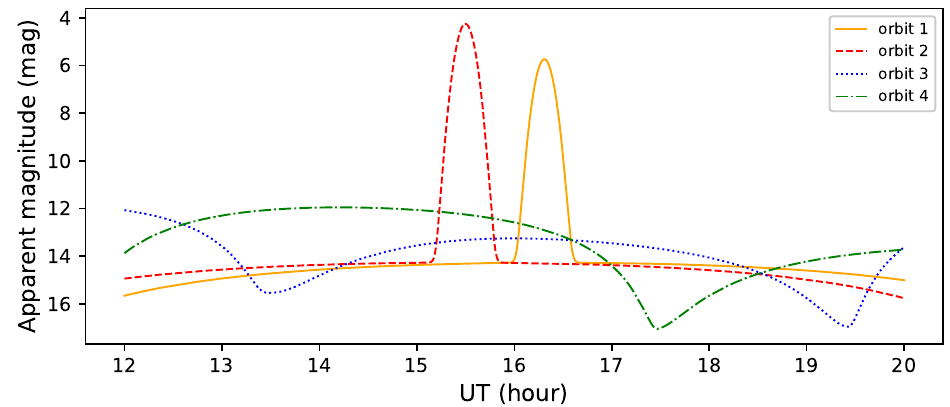
Figure 2. Synthetic light curves for different orbits.